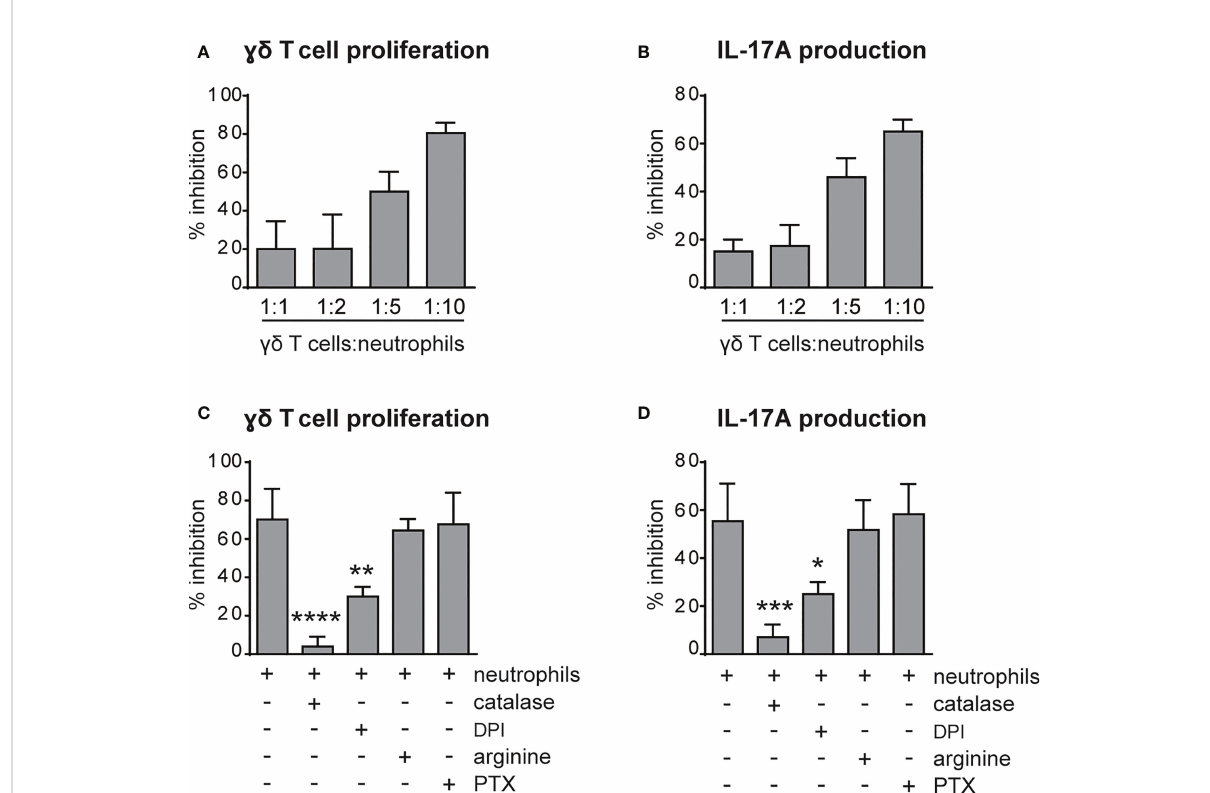
FIGURE 5 Neutrophils inhibit the proliferation and IL-17 production by gd T cells via reactive oxygen species (ROS) production. (A, B) gd T cells were stimulated with CD3/CD28, 100 ng/ml IL-23 plus 10 ng/ml IL-1 b and cultured for 72h in the presence or absence of neutrophils at different ratios. (C, D) gd T cells were stimulated with CD3/CD28, 100 ng/ml IL-23 plus 10 ng/ml IL-1 b and cultured for 72h with neutrophils added at a 1 to 5 gd T to neutrophil cell ratio, with or without inhibitors: catalase (1000 U/ml), diphenyleneiodonium (DPI) (0,1 m M), L-arginine (200 m g/ml-1), pentoxi fi llin (PTX) (0,5 m M). The percentages of inhibition of proliferation, as measured by BrdU incorporation (A, C) , or IL-17A production (B, D) by gd T cells, are reported. Graph values indicate means ± SD from 2 to 3 independent experiments. Statistical differences of the effect of neutrophils in the presence or absence of inhibitors are reported. *P ≤ 0.05; **P ≤ 0.01; ***P ≤ 0.001; ****P ≤ 0.0001 by 1-way ANOVA with Dunnett ’ s